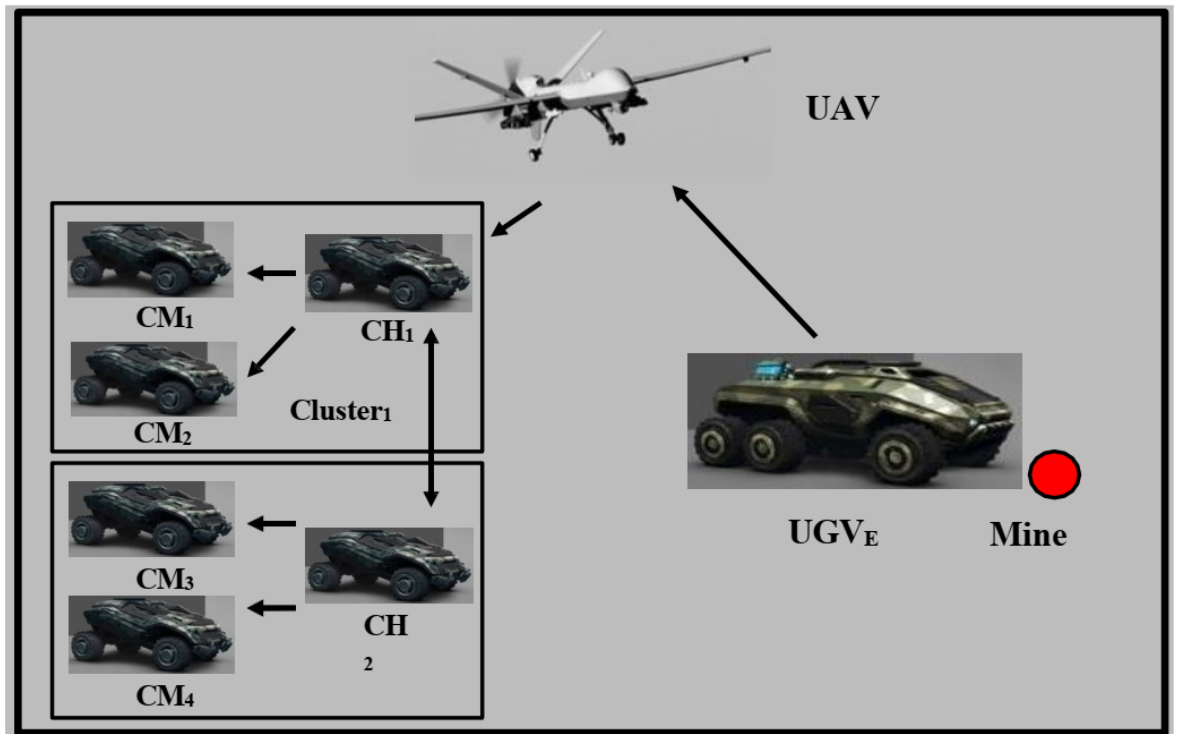
Figure 2. Event message dissemination by UGV to UAV and incoming UGVs.